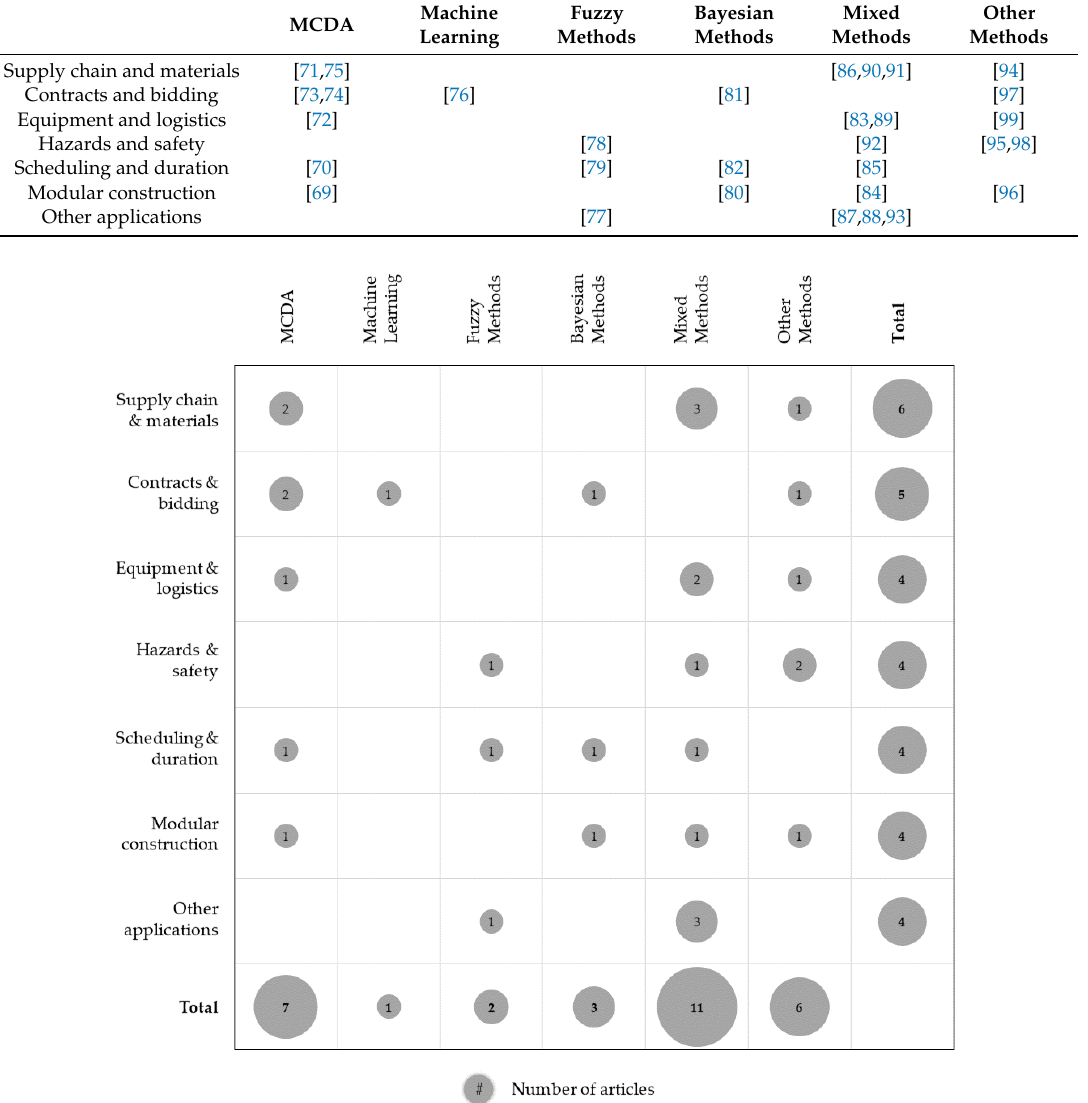
Table 3. Construction phase. Categorization of articles with application areas and methods.